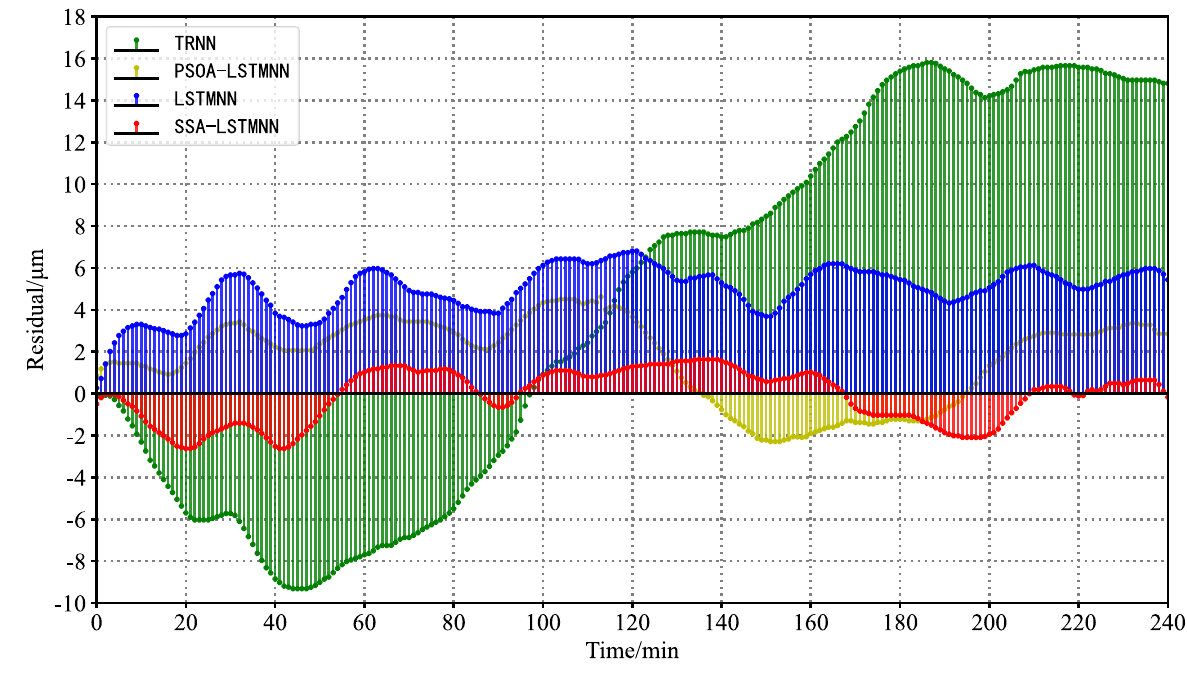
Figure 21. Residual curves for each model at velocity V 3 = 8000 mm/min.